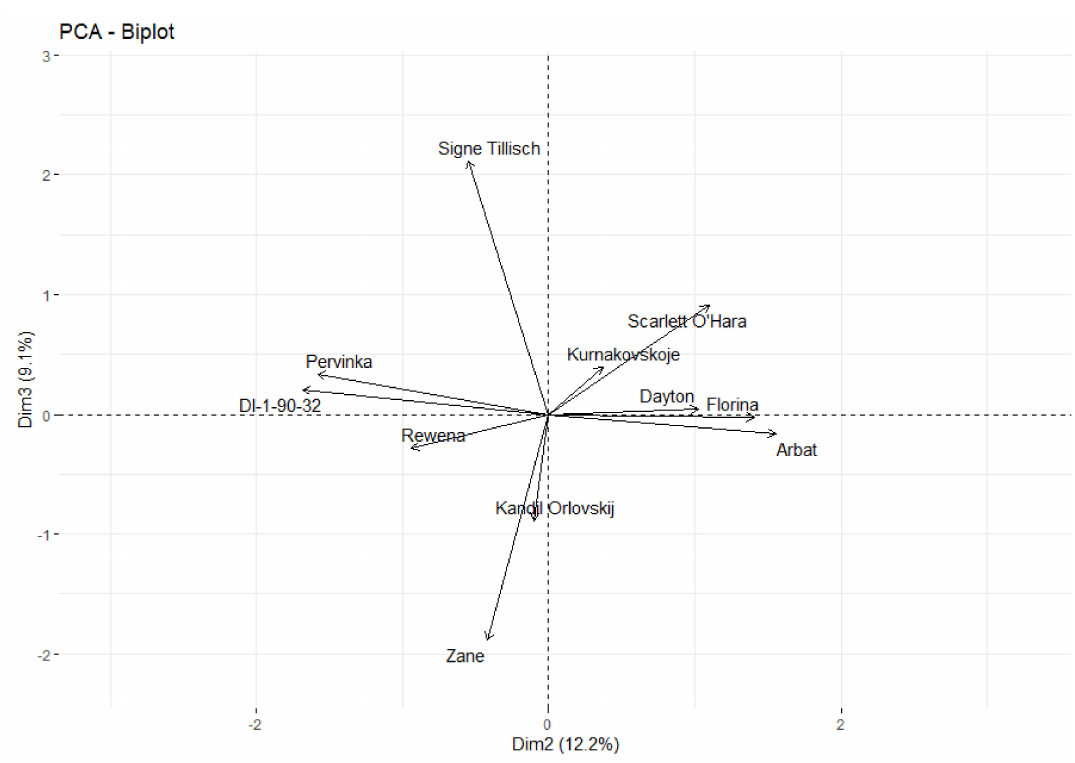
Figure 6. PCA analysis of genetic relatedness of parental genotypes using 22 SSR markers.